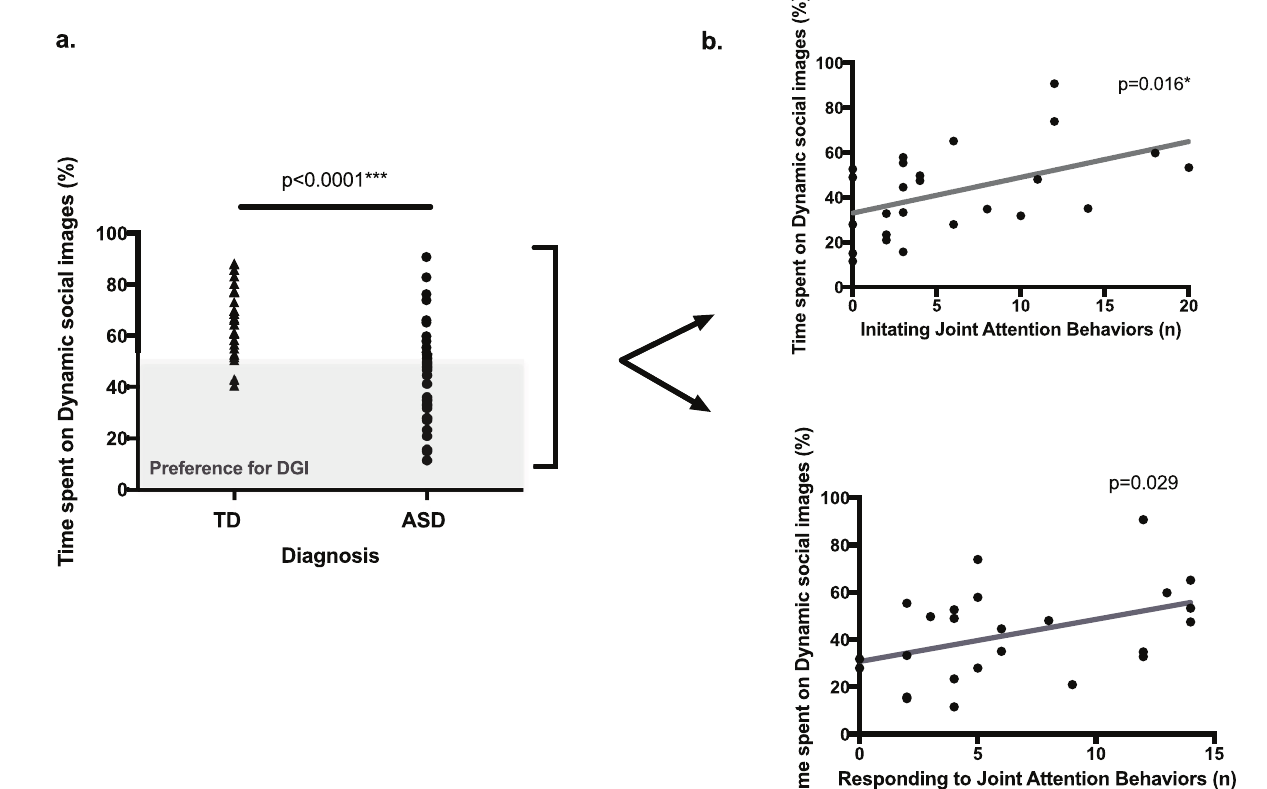
Fig 2. a. Differencesin percentage of time spent on DSI for the DSI-TASK task betweenthe ASD and TD groups. Participants represented in the grey zone preferredDGI. b. Correlations for each group betweentime spent on DSI duringthe DSI-TASK and IJA and RJA from the